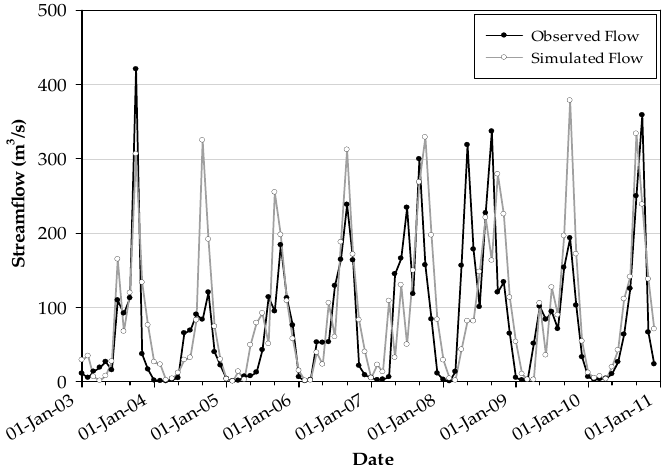
Figure 5. Comparison between monthly simulated and observed